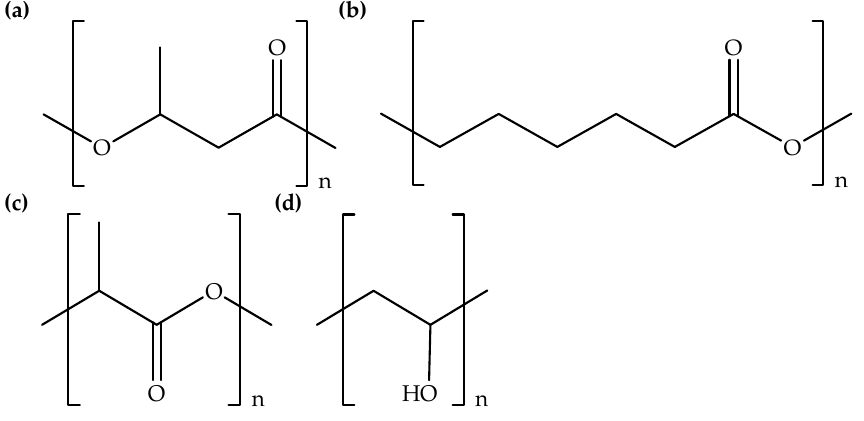
Figure 2. Chemical structures of ( a ) PHB, ( b ) PCL, ( c ) PLA, and ( d ) PVA.